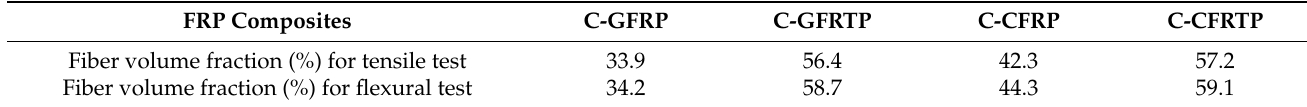
Table 3. Fiber volume fraction of all